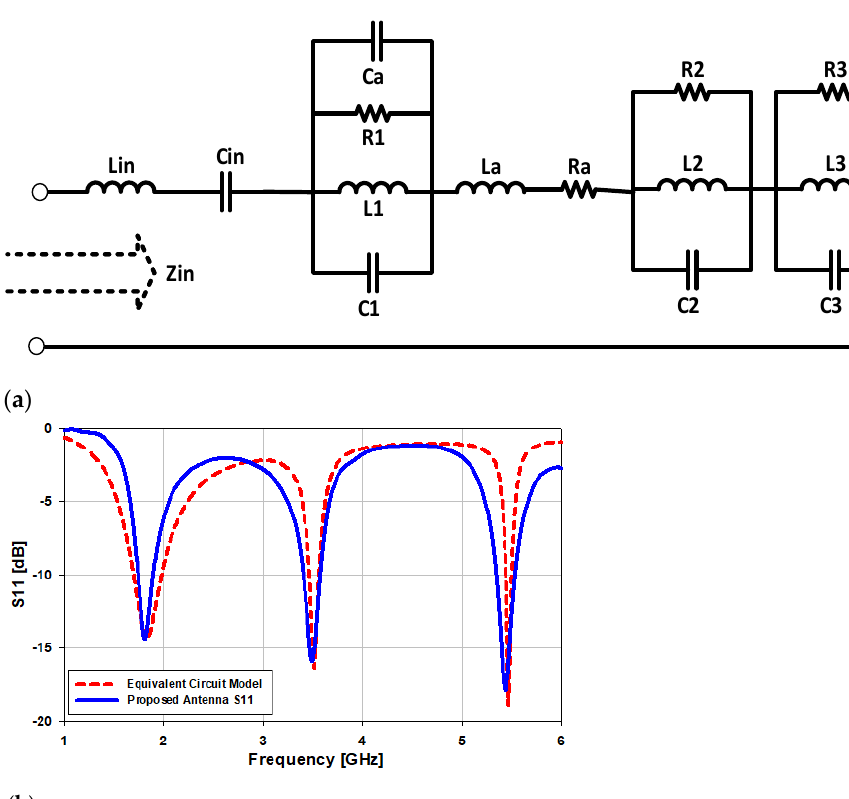
Figure 6. ( a ) Proposed equivalent circuit model for the triband antenna; ( b ) S 11 obtained from the circuit model. Table 2. Lumped element component values of the equivalent circuit model.